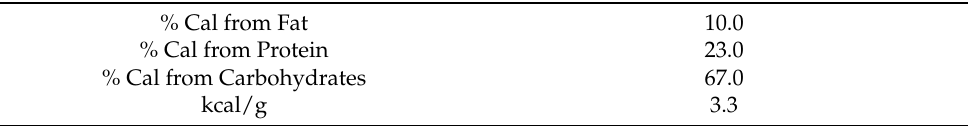
Table 1. Macronutrient ratios of rodent standard diet (more details about the ingredients of diet can be found in Supplementary Figure